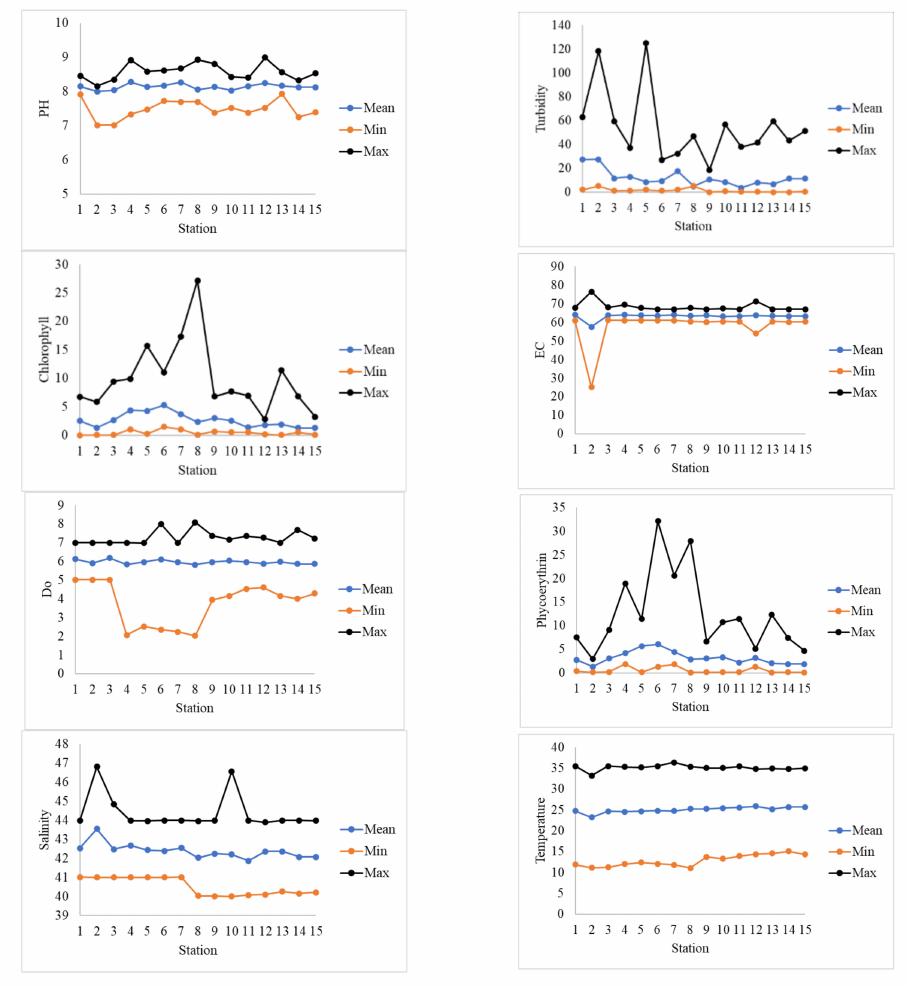
Figure 2. Maximum, mean, and minimum values of the measured parameters at each station in 2017.